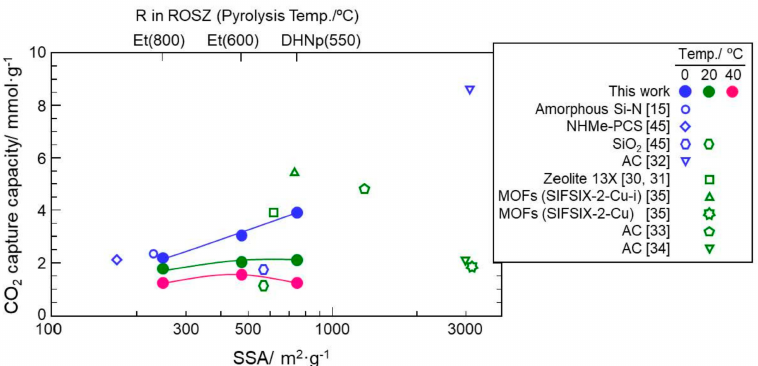
Figure 12. CO 2 capture capacity vs. SSA of ROSZ-derived amorphous Si–O–N